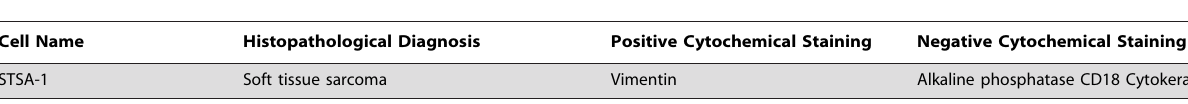
Table 1. Staining characteristics of cells isolated from a spontaneous tumor growth on a golden retriever dog.